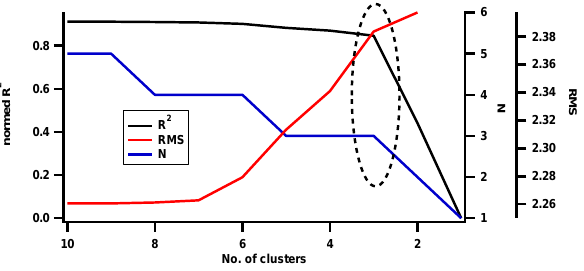
Fig. 2. Average-linkage statistics. The optimum solution as indicated by the statistics is highlighted.